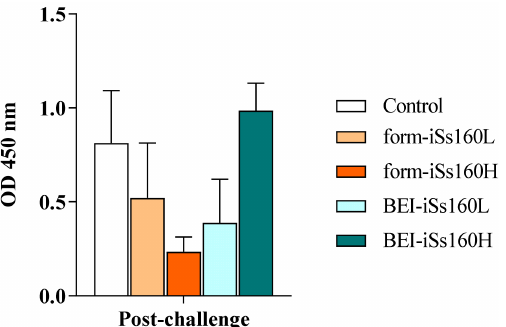
Figure 5. Vaccination does not alter specific humoral immunity upon NNV infection. Specific anti- NNV IgM levels in the serum of Senegalese sole specimens 45 days after 3 h of immersion with 10 5 TCID 50 /mL of Ss160 in previously intraperitoneally vaccinated Senegalese sole specimens vaccinated with low and high dosages (10 5 and 10 7 TCID 50 /mL, iSs160L and iSs160H, respectively) of BEI-iSs160 vaccine (inactivated with BEI) and form-iSs160 (formalin inactivated) or PBS (Control). Infection was performed by 3 h of immersion with 10 7 TCID 50 /mL. Data represent the mean ± standard error of the mean (SEM; n = 6 fish/group and time). Statistical assay was performed by the two-way ANOVA test ( p < 0.05).